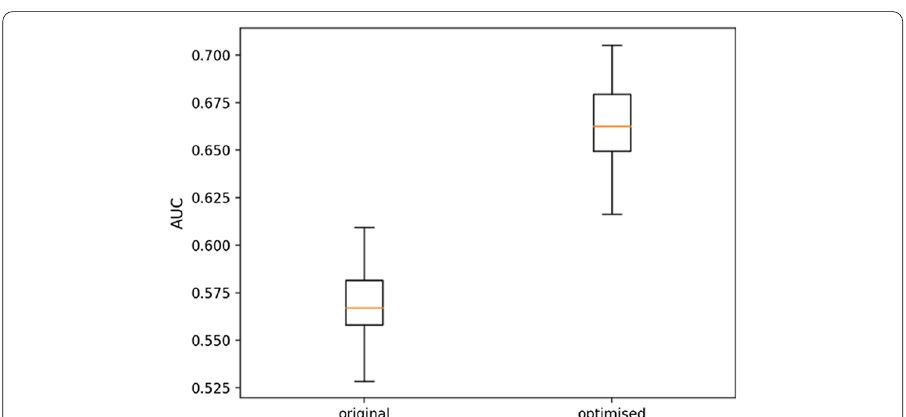
Fig. 10 A box plot of the 30-trial evaluation of performance predication models by AUC